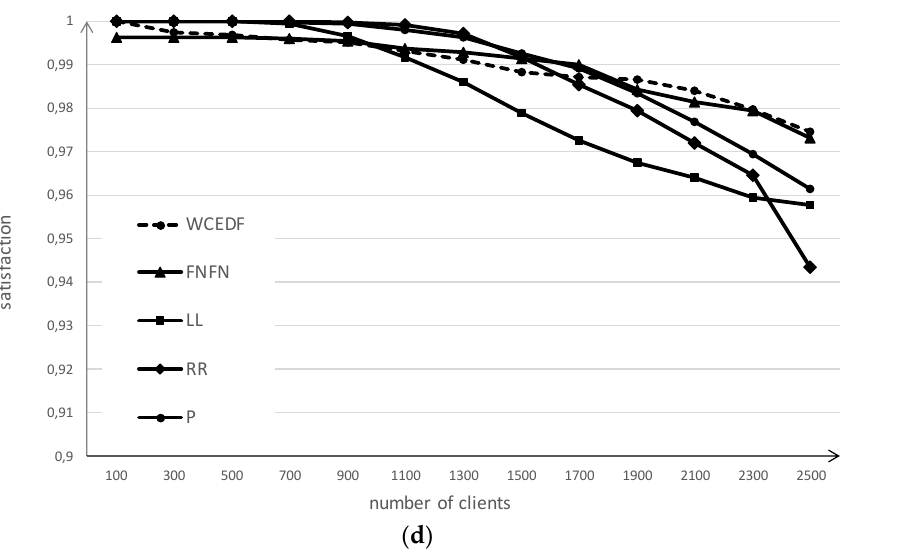
Figure 7. Satisfaction in load function for different 𝑡 𝑚𝑎𝑥 times. ( a ) 𝑡 𝑚𝑎𝑥 𝑠 = 0.5 s,𝑡 𝑚𝑎𝑥 ℎ = 1 s ; ( b ) 𝑡 𝑚𝑎𝑥𝑠 = 0.75 s, 𝑡 𝑚𝑎𝑥ℎ = 1.5 𝑠 ; ( c ) 𝑡 𝑚𝑎𝑥𝑠 = 1 s, 𝑡 𝑚𝑎𝑥ℎ = 2 s ; and ( d ) 𝑡 𝑚𝑎𝑥𝑠 = 2 s,𝑡 𝑚𝑎𝑥ℎ = 4 s .